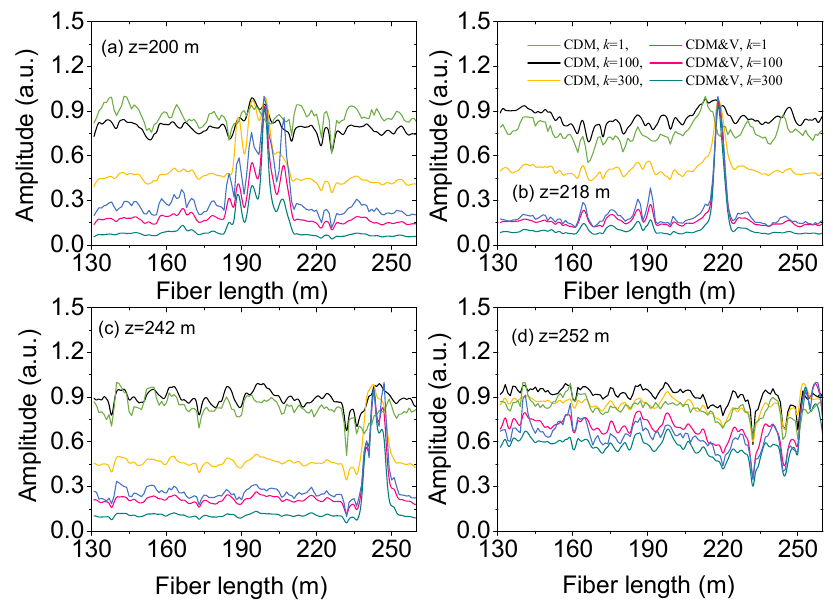
Figure 4. Synthesized detection signals obtained by the CDM and CDM&V when the vehicle is driving over the campus road. ( a ) z = 200 m, ( b ) z = 218 m, ( c ) z = 242 m, and ( d ) z = 252 m.